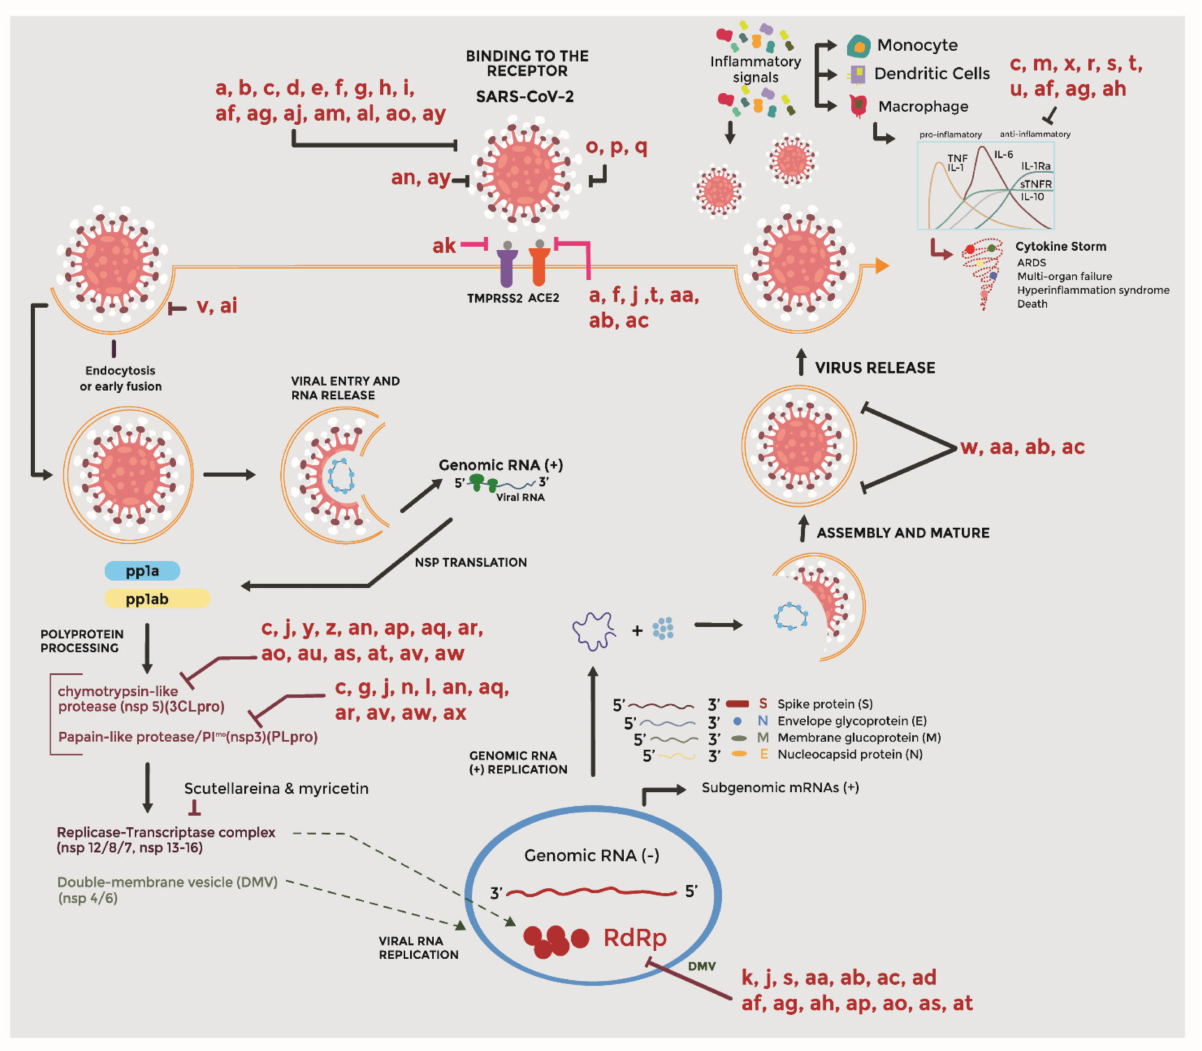
Figure 1. Various active principles and their mechanism of action. The infection cycle of SARS-CoV-2 in human cells. The SARS-CoV-2 spike (S) protein binds to ACE2 in host cells followed by priming of protein S by transmembrane protease serine 2 protease (TMPRSS2). Then, the virus produces the polyproteins pp1a and pp1ab, which are processed by viral proteases (3CLpro/Mpro, PLpro) to non-structural proteins (nsps), including RNA-dependent RNA polymerase (RdRp). Viral RdRp synthesizes a full-length complementary negative-strand RNA as a template for the production of the positive strand genome of the virus. Subgenomic mRNAs are then translated into structural proteins in the rough endoplasmic reticulum or in the cytosol. The viral genomic RNA is encapsulated by the nucleocapsid protein N and, finally, the virus is released by exocytosis. The blunt arrows indicate the possible targets of the active principles of medicinal plants. Irreversibly interference with viral docking receptors: Caphtharic acid ( o ), cichoric acid and echinacoside from Echinacea purpurea ( p ), vitamins D, C and Zn ( q ). Entry locks: Emodin ( a ), lectins ( b ), quercetin ( c ), catechin ( d ), naringenin ( e ), hesperetin ( f ), baicalin ( g ), epigallocatechin ( h ), gallocatechin gallate ( i ), prodelphinidin ( af ), gallocatechin ( ag ), saikosaponins derivatives of oleanane from Heteromorpha arborescens and Bupleurum spp. ( aj ), glycyrrhizine ( al ), Licorice ( am ), desmethoxyreserpine ( ao